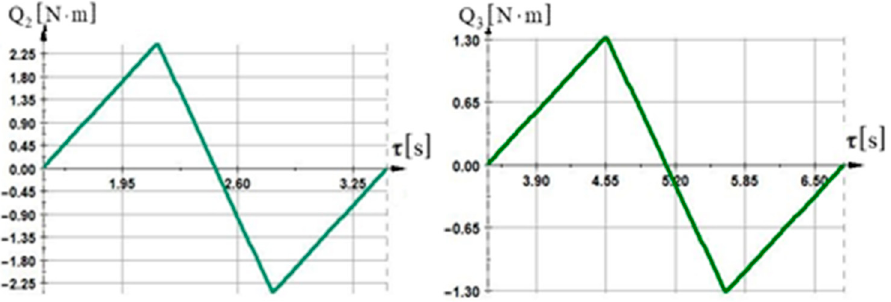
Figure 8. Variation of driving moments over time for joints j = 2 and j = 3.